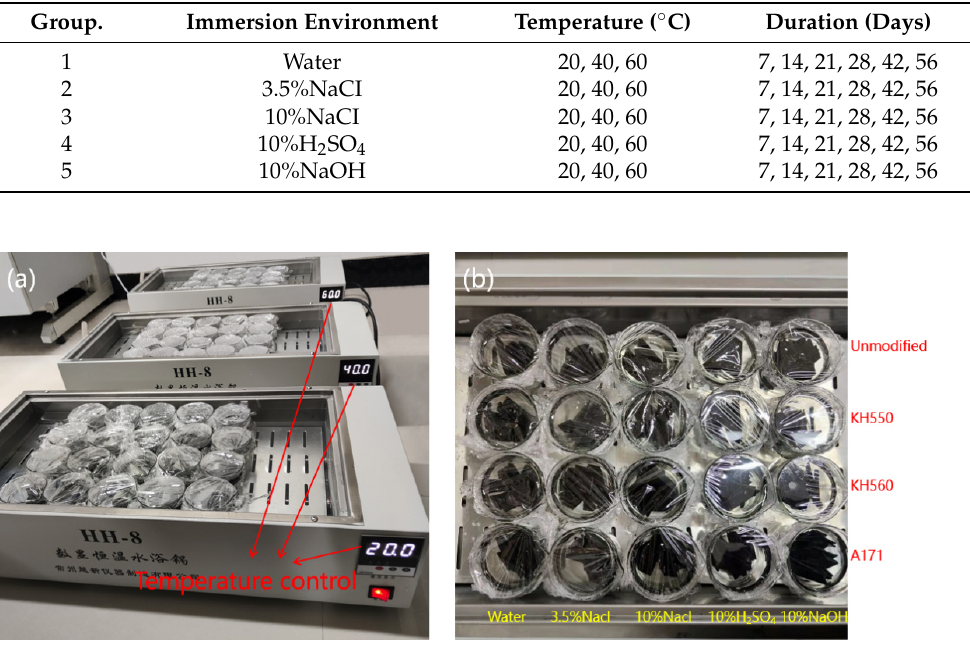
Figure 3. Immersion experiment: ( a ) immersion experiment equipment; ( b ) close-up view of immersed samples.